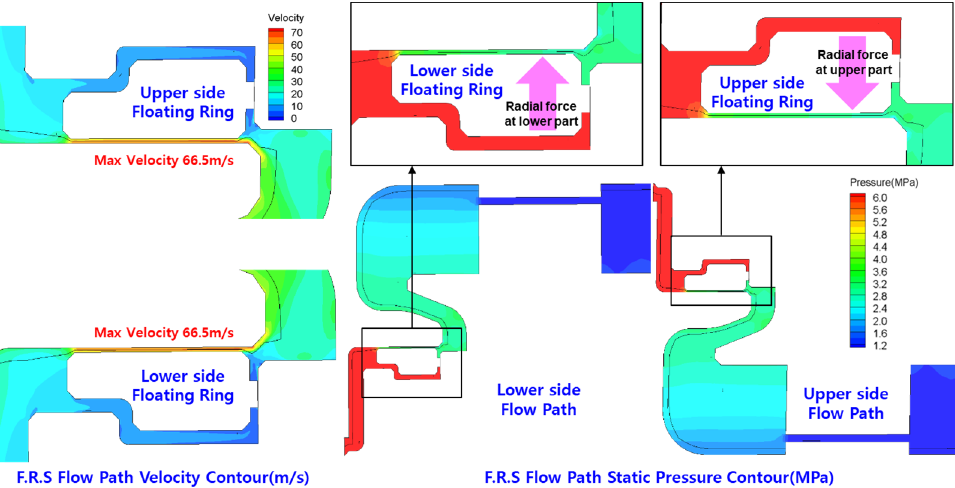
Figure 14. Velocity (m/s) and static pressure (MPa) distributions without difference in gap size of floating ring.